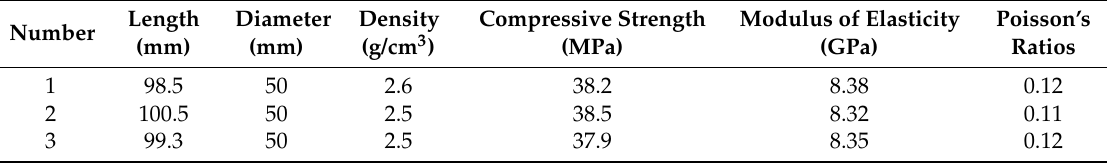
Table 2. Physical and mechanical properties of the rock specimens.